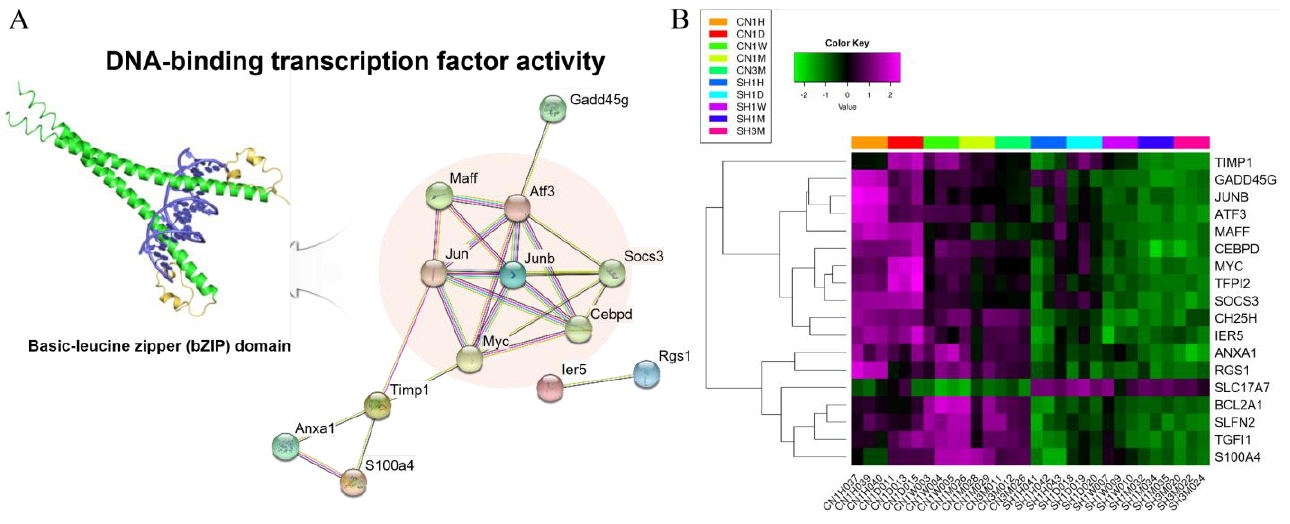
Figure 6. Common factors in maintaining transcriptional change over five time periods. ( A ) protein– protein interaction network based on the 18 common DEGs in all comparisons; STRING analysis mapped a network containing 13 DEGs. The remarkable genes containing basic-leucine zipper (bZIP) transcription factor domains are the seven genes in the orange circle. Each node represents a protein, and each edge represents an interaction. ( B ) The common DEGs (17 up- and 1 downregulated) showing significant changes after SCI are visualized by heatmap clustering. The legend and top color key show the experimental cases and the number of expression values,